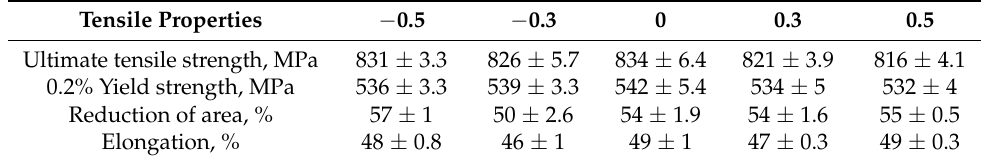
Table 4. Tensile properties of specimens built with different defocusing